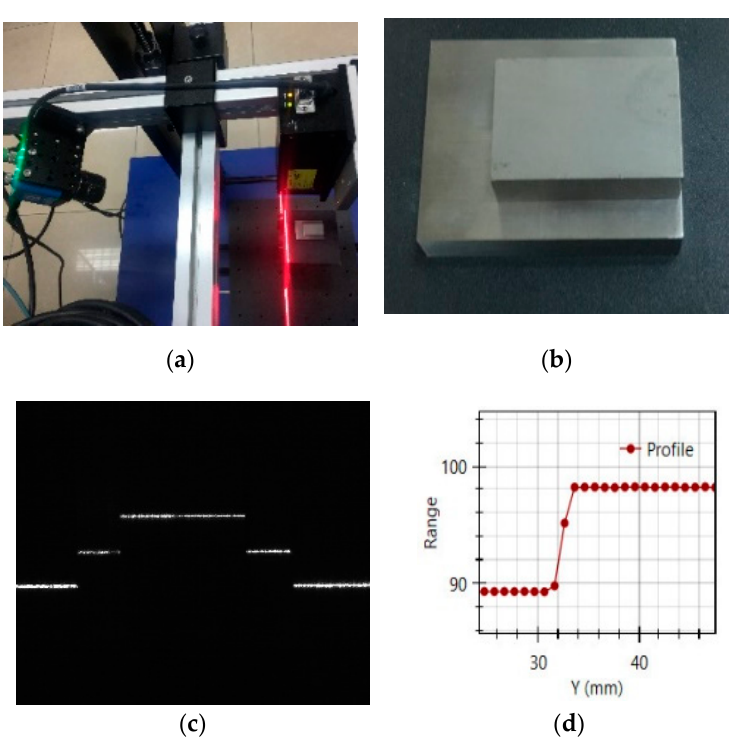
Figure 10. Static measurement precision validation: (a) Measuring device; (b) two standard blocks; (c) profile image of standard block; (d) measured profile for standard blocks.